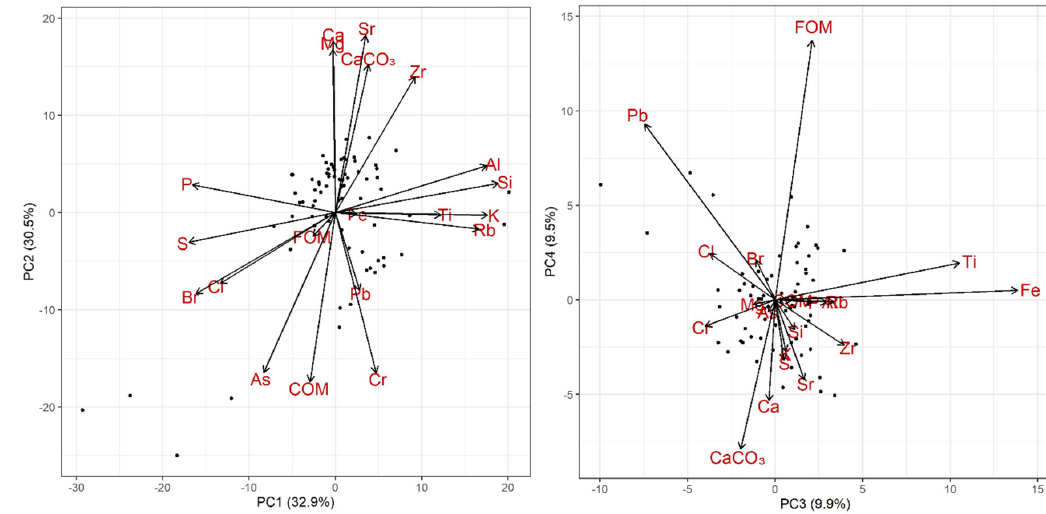
Figure 4. PCA loadings (black arrows). The black dots represent the samples distribution according to their scores in the plotted principal components.